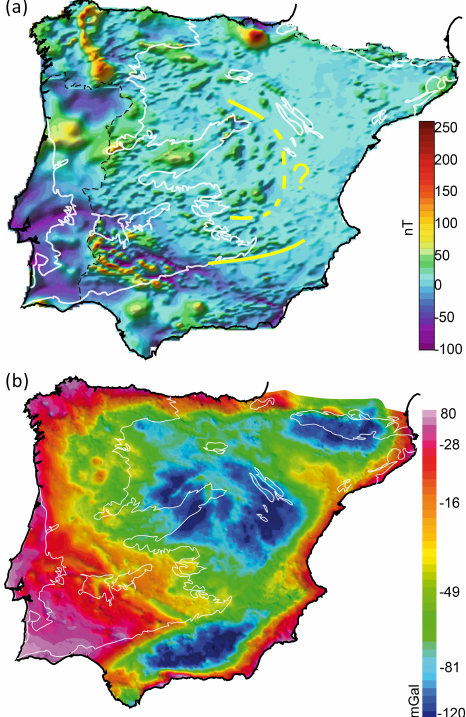
Figure 5. (a) Aeromagnetic map of Spain (Ardizone et al., 1989, for Spain and the World Digital Magnetic Anomaly Map, WDMAM, project) and Portugal (modified from Martínez Catalán, 2012, and Martínez Catalán et al., 2015) showing the possible trace of the Cen- tral Iberian curve. (b) Bouguer anomalies of the Iberian Peninsula, modified from Ayala et al. (2016). Gravity anomalies do not re- flect the geometry of the Cantabrian Orocline or the Central Iberian curve but are related to the Cenozoic Alpine lithospheric